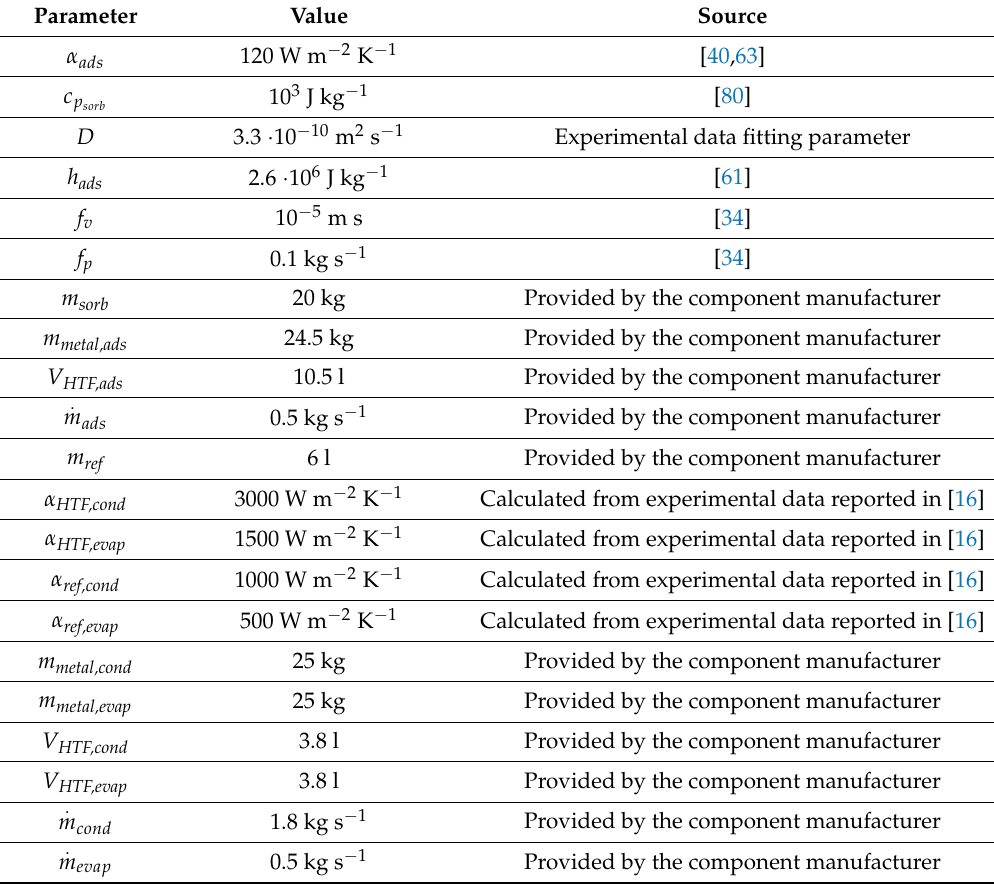
Table A2. Parameters used in the model of the adsorption